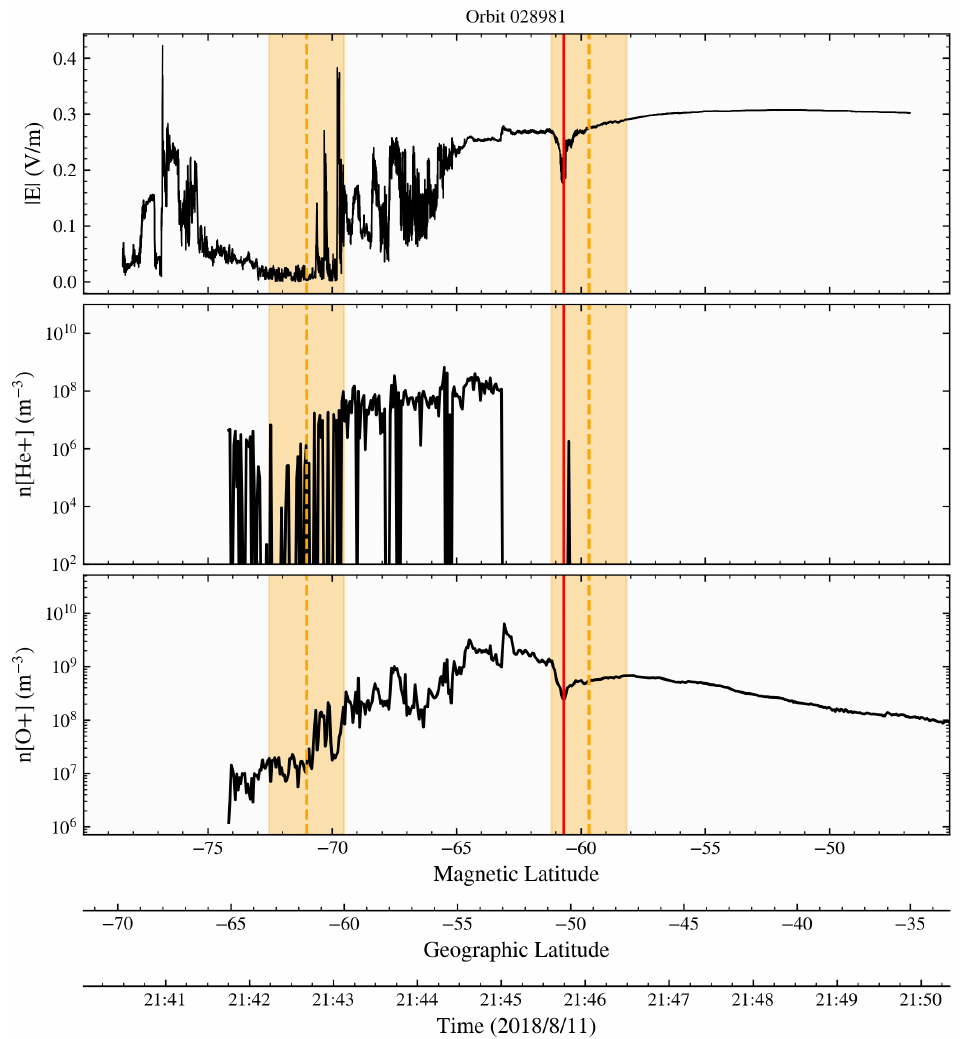
Figure 2. Electric field amplitude ( top ) and He+ ( middle ) and O+ ( bottom ) density as taken by PAP [24]. The vertical dashed orange lines and areas are the same as in the left panel of Figure